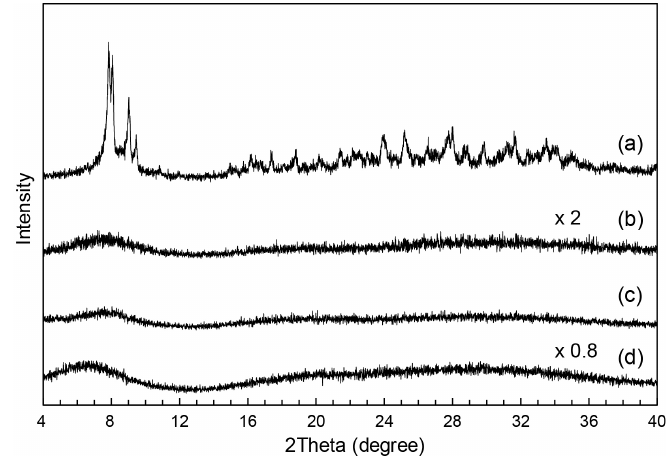
Figure 6. Powder X-ray diffraction patterns of MAImC 1 -PW 12 hybrids: ( a ) P-MAImC 1 -PW 12 hybrid homopolymer prepared by using DMSO; ( b ) P-MAImC 1 -PW 12 hybrid homopolymer prepared by using DMF; ( c ) CP-MAImC 1 -PW 12 /BMA hybrid copolymer; and ( d ) CP-MAImC 1 -PW 12 /MAImC 8 Br